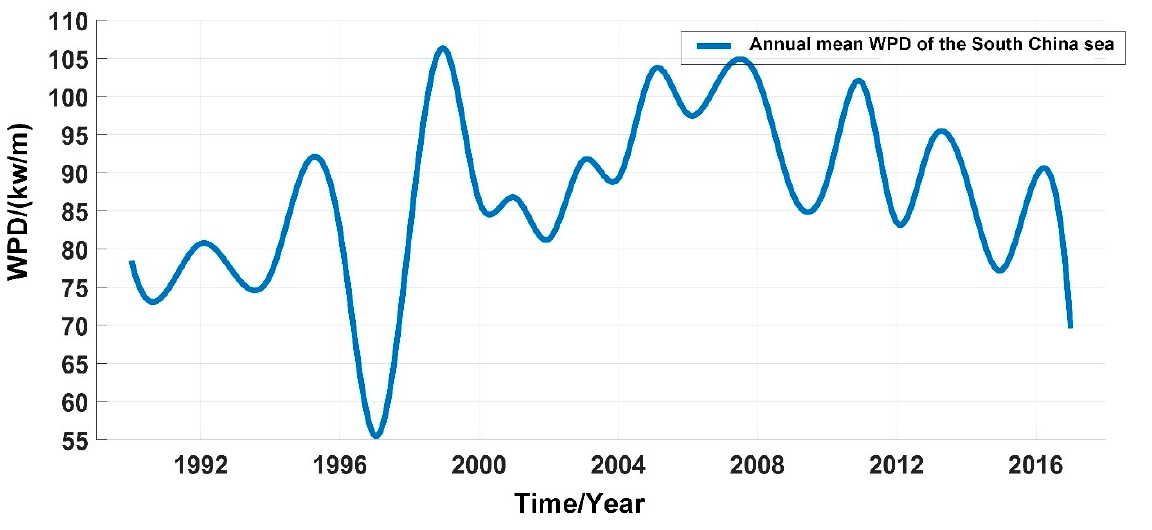
Figure 6. Annual variation of WPD in the South China Sea.